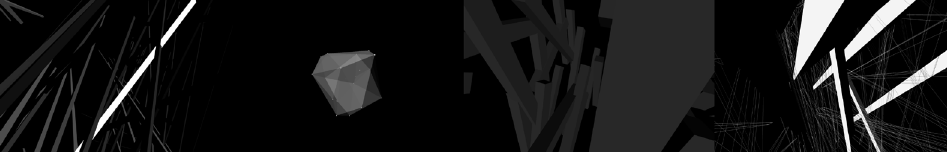
Figure 2: Screenshots of the four default graphical scenes of